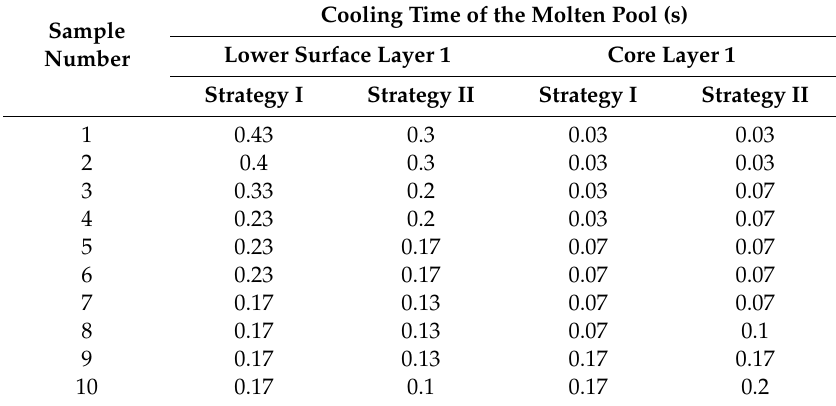
Table 3. The cooling time of the molten pool during the processing of different samples in Lower surface layer 1 and Core layer 1.